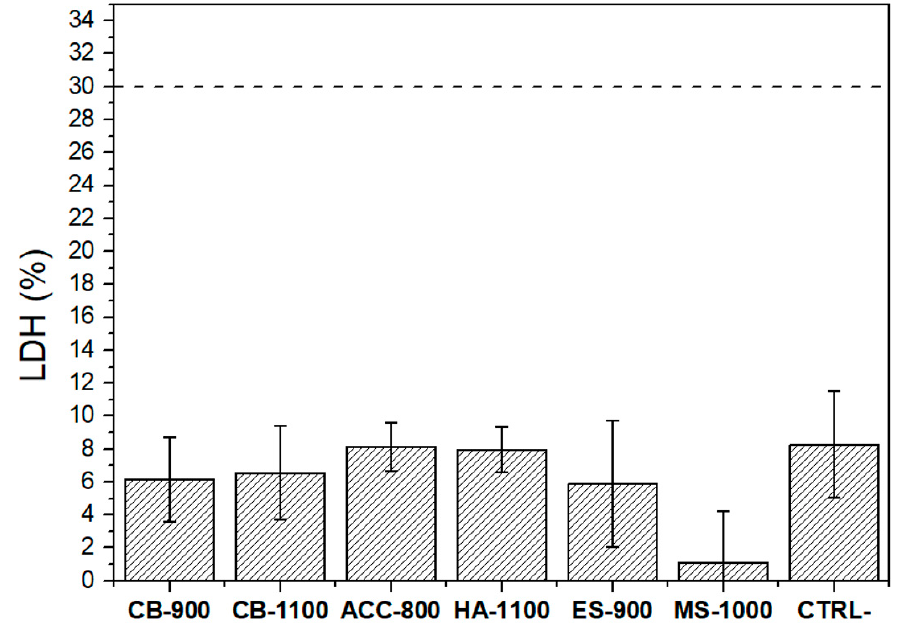
Figure 4. The LDH levels of the sintered pellets. The cytotoxicity threshold (30%) is indicated by the dashed line.